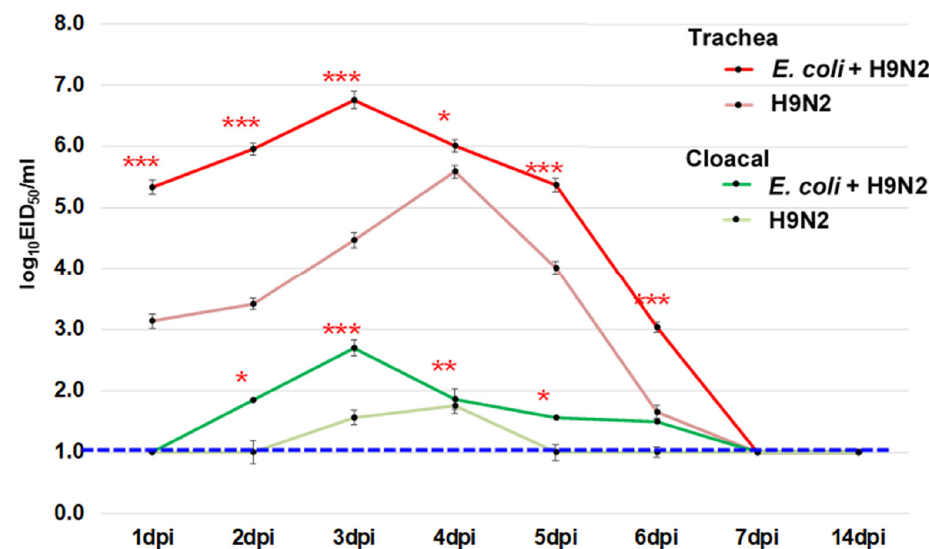
Figure 7. The virus recovery from the trachea and cloacal swabs in chickens. Chickens were inoculated intranasally with 10 9.0 CFU of E. coli O2 two days prior to challenge of 10 6.0 EID 50 of a representative H9 LPAIV (A/chicken/Vietnam/HU8-1860/2017 (H9N2) in the red circle in Figure 1). The swabs were taken from 1 to 14 dpi. Bars indicate the standard error of mean. Statistical significance was calculated using Tukey’s test. Significant differences in viral titers between groups are indicated by * ( p < 0.05), ** ( p < 0.01), and *** ( p < 0.001). The dotted line indicates the detection limit of the test.